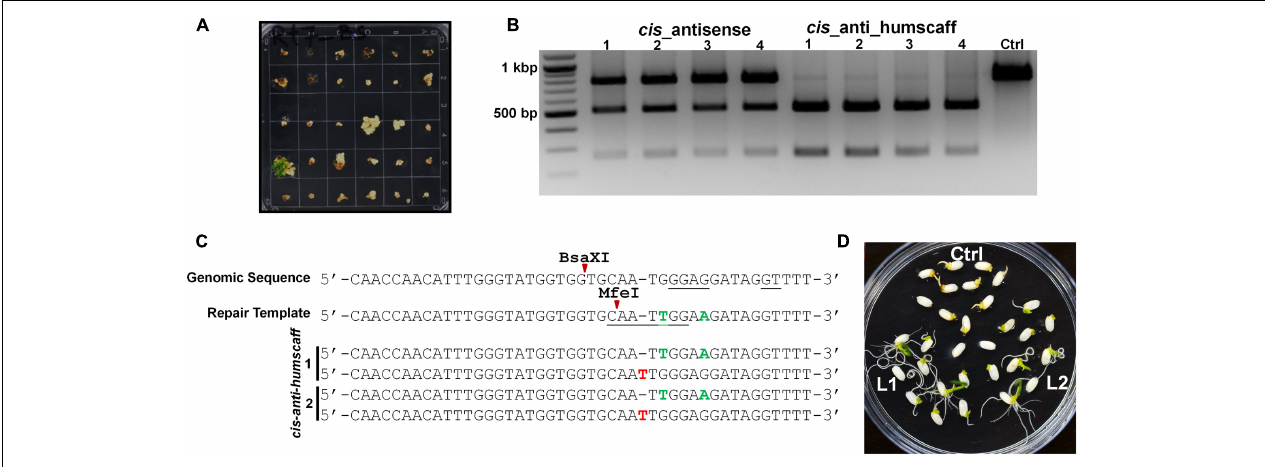
FIGURE 3 | RNA-templated DNA Repair produced Herbicide-resistant Plants. (A) In OsALS Tryptophan (TGG) to leucine (TTG) at amino acid 548 (W548 L) showed high bispyribac sodium (BS) herbicide resistance. The transformed calli were regenerated with BS. The seedlings transformed with cis_anti_humscaff repair template have stronger resistance and are well-established. (B) DNA was extracted from young seedlings and mutations were detected by MfeI digestion. The plants with desired mutations showed digested bands and the control showed an MfeI-resistant undigested band. (C) These amplicons were cloned and Sanger sequenced. The seedlings with the cis_anti_humscaff repair template showed repair (green nucleotides). Red nucleotides show other Indels. (D) Seeds from cis_antis_humanscaff repair template BS-resistant plants were germinated on 1 / 2 MS+0.75 µ M BS and showed clear BS resistance. These resistance plants were Sanger sequenced and showed homozygous repair (Supplementary Figure